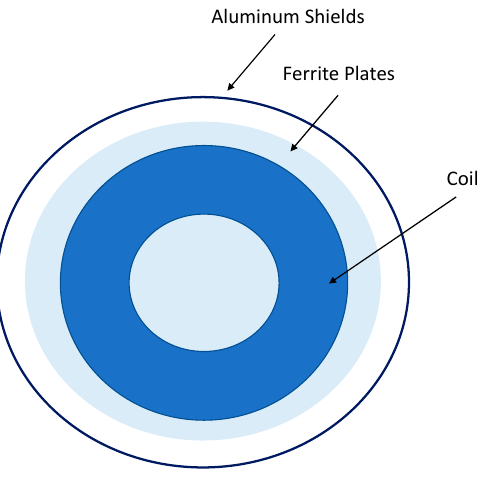
Figure 3. Circular pad (CP) design [10].